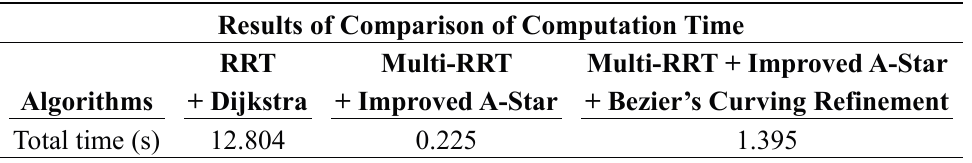
Table 4. Comparison of computational